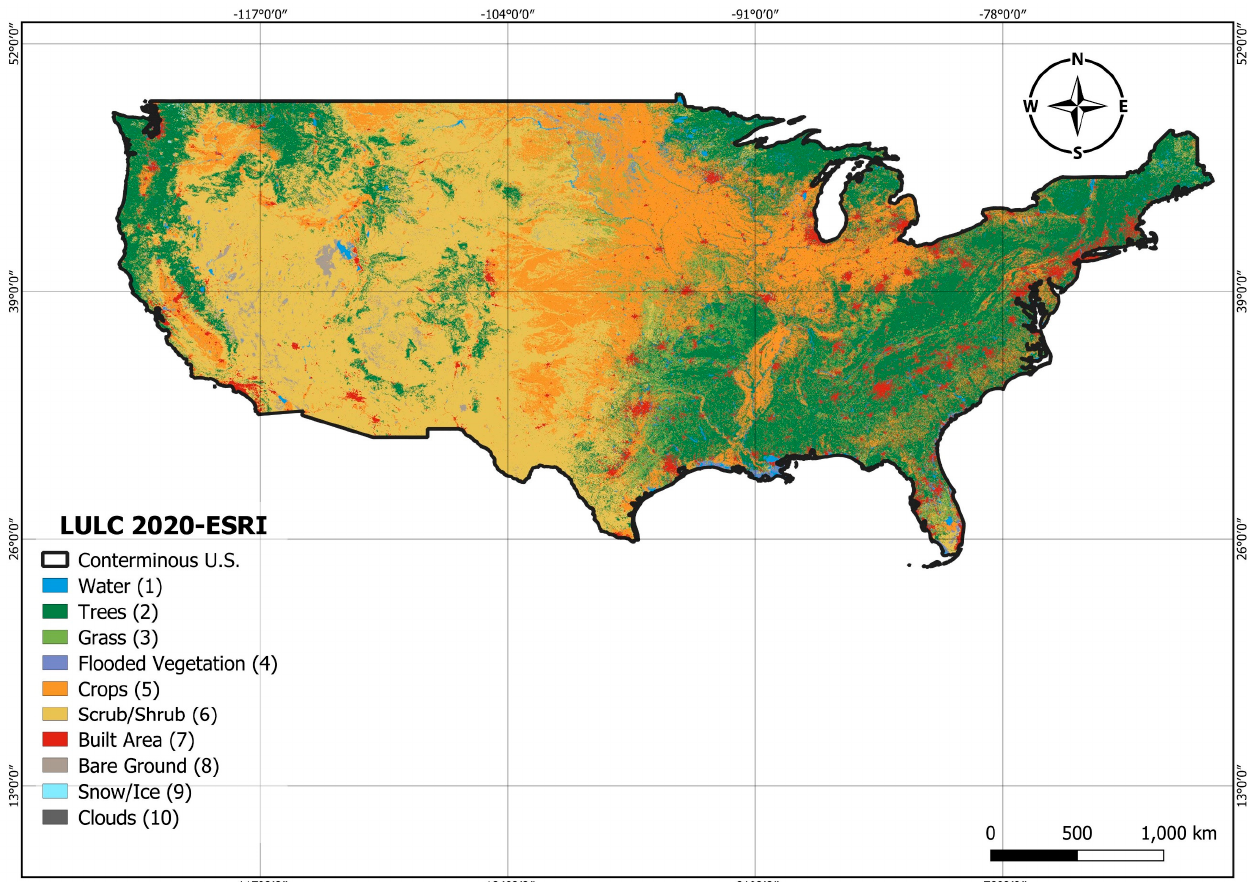
Figure 2. LULC 2020-ESRI classifications for conterminous United States only [33].